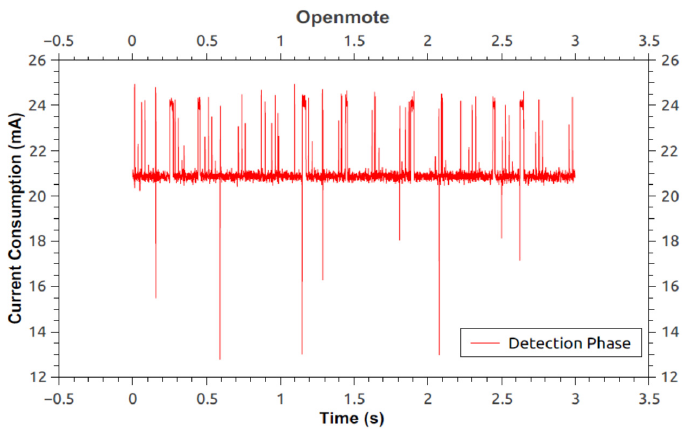
Figure 17. Current consumption of OpenMote running modified protocol during detection phase—nullrdc.